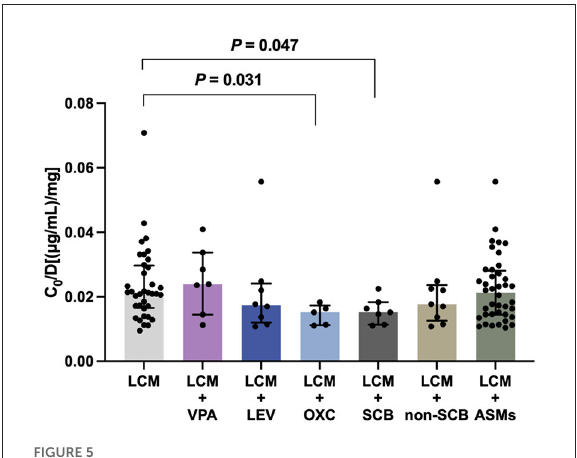
FIGURE5 The C 0 /Dose ratio [( µ g/mL)/mg] of LCM in polytherapy. A comparison of C 0 /Dose ratio between monotherapy and coadministration with valproic acid (VPA), levetiracetam (LEV), oxcarbazepine (OXC), sodium channel blocking (SCB) agents and non-SCB